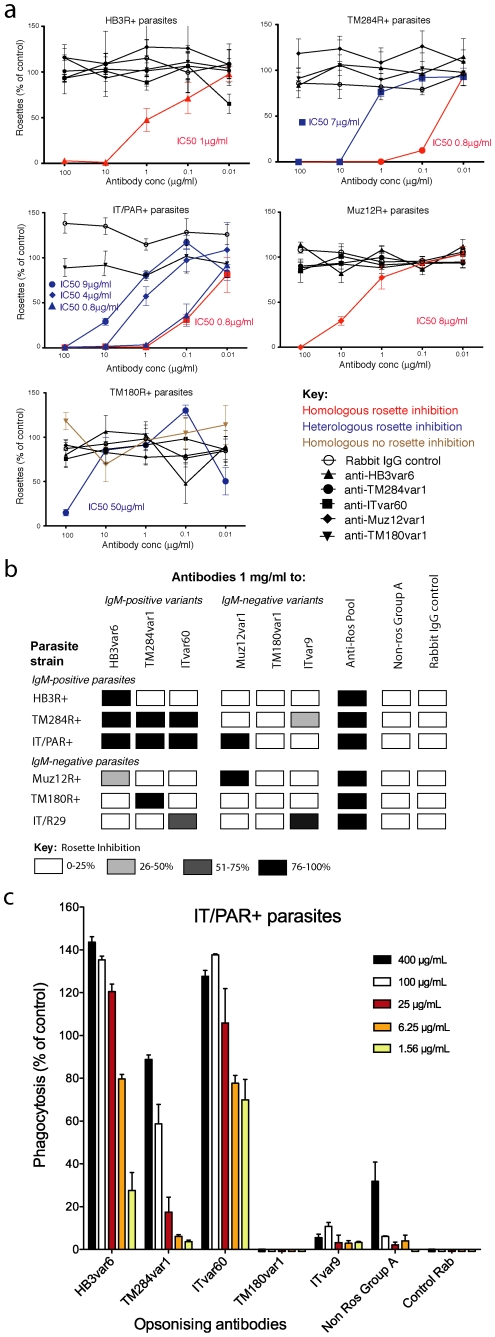
Polyclonal antibodies to PfEMP1 inhibit rosetting and induce phagocytosis of heterologous rosetting laboratory strains.a) Rosette inhibition assays to determine the dose-dependent effects of PfEMP1 antibodies on homologous and heterologous rosetting laboratory strains. Data are compared to a control with no added antibody, which contained at least 40% of IEs in rosettes. Mean and standard deviation of triplicate values are shown. IC50: concentration of antibody giving 50% rosette inhibition. b) Rosette inhibition assay as above with 1 mg/ml of antibody, except for the Anti-Ros pool which consisted of a mixture of 0.1 mg/ml of each antibody (to HB3var6, TM284var1, ITvar60, Muz12var1, TM180var1 and ITvar9). Controls are as for Figure 4b. c) Phagocytosis assay of opsonised IT/PAR+ IEs co-incubated with the monocytic cell line Thp-1 [13]. Data are shown as percentage of the positive control opsonised with a rabbit anti-human erythrocyte antibody. Both homologous and heterologous antibodies induce phagocytosis of IT/PAR+ IEs. Control Rab: negative control of IgG from a non-immunized rabbit.